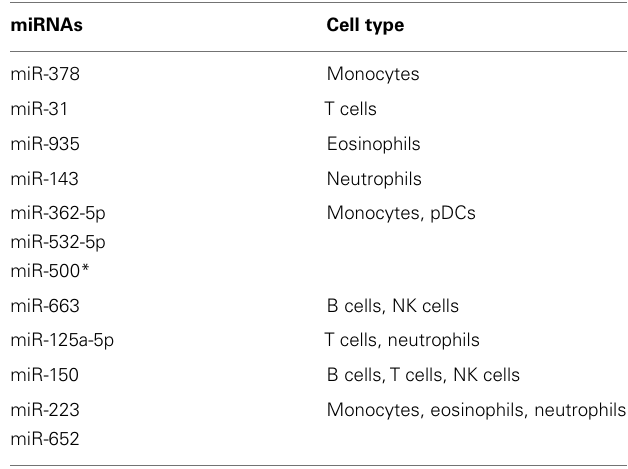
Table 2 | List of cell-specific miRNAs in whole blood of normal individuals [adopted from Ref.